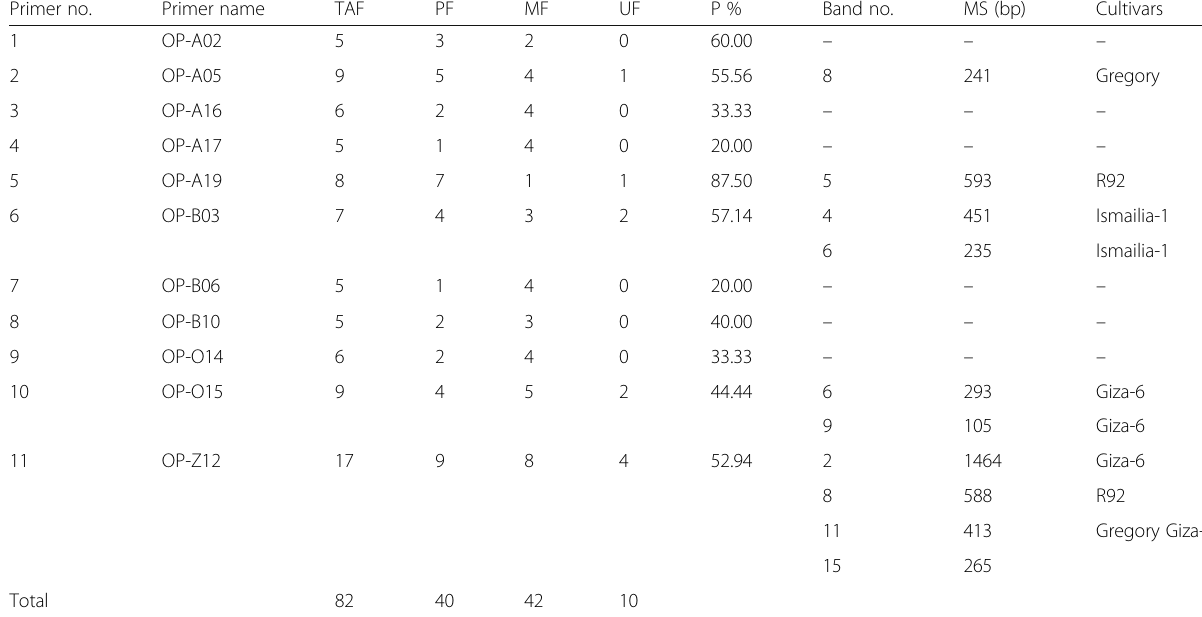
Table 5 The number of total amplified fragments, polymorphic fragments, polymorphism percentage, and specific markers using RAPD analysis Primer no.